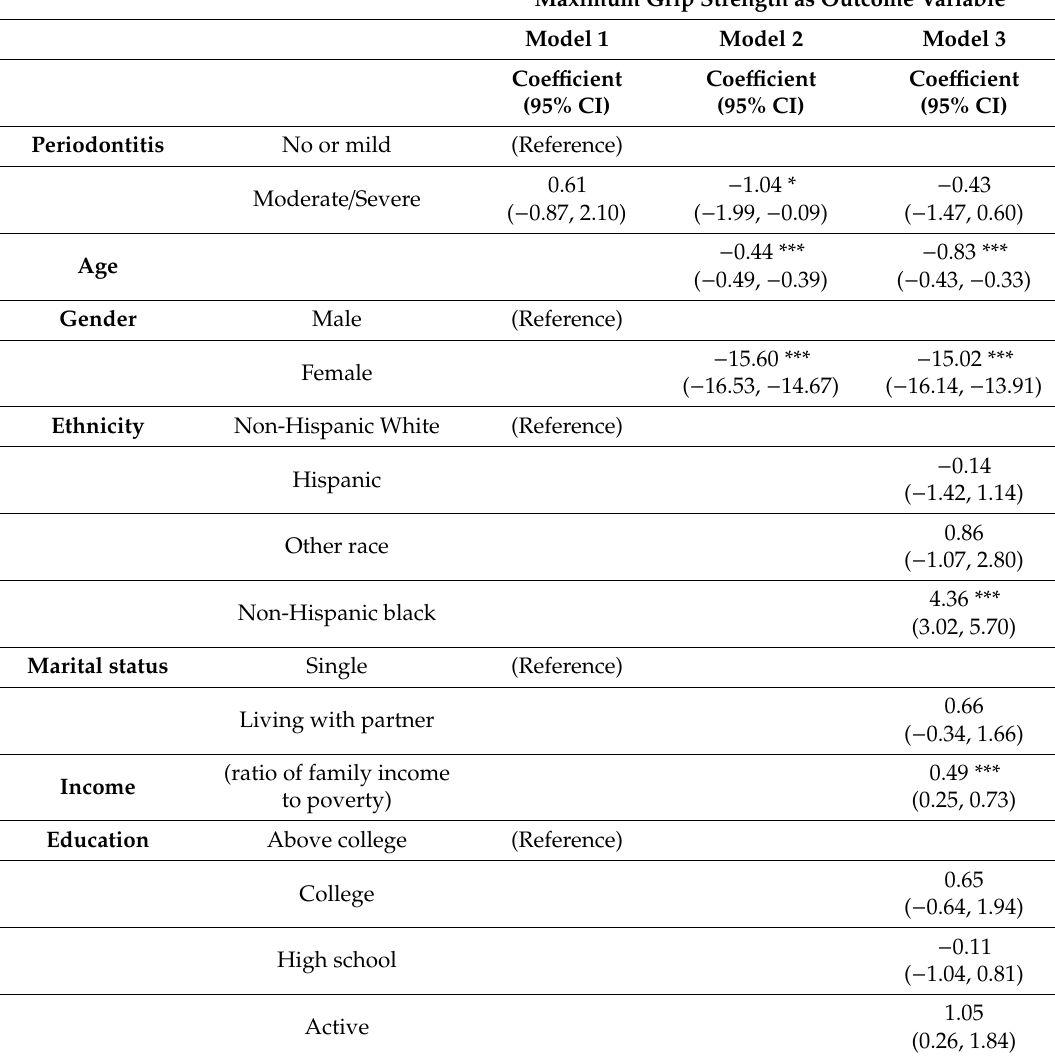
Table 3. Linear regression models showing the associations between Periodontal disease and low grip strength among the study sample ( N =